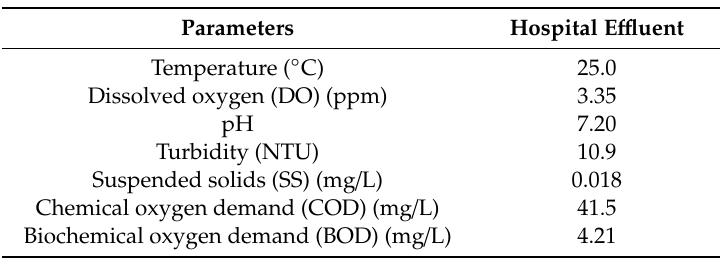
Table 3. Characteristics of hospital effluent.